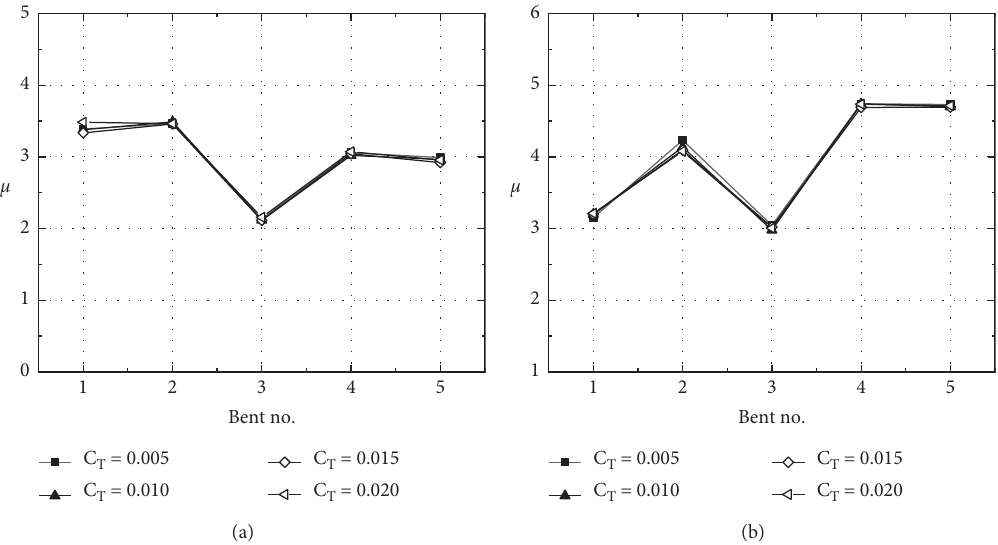
Figure 21: Effect of C T on the displacement ductility demands of bents. (a) Longitudinal direction. (b) Transverse